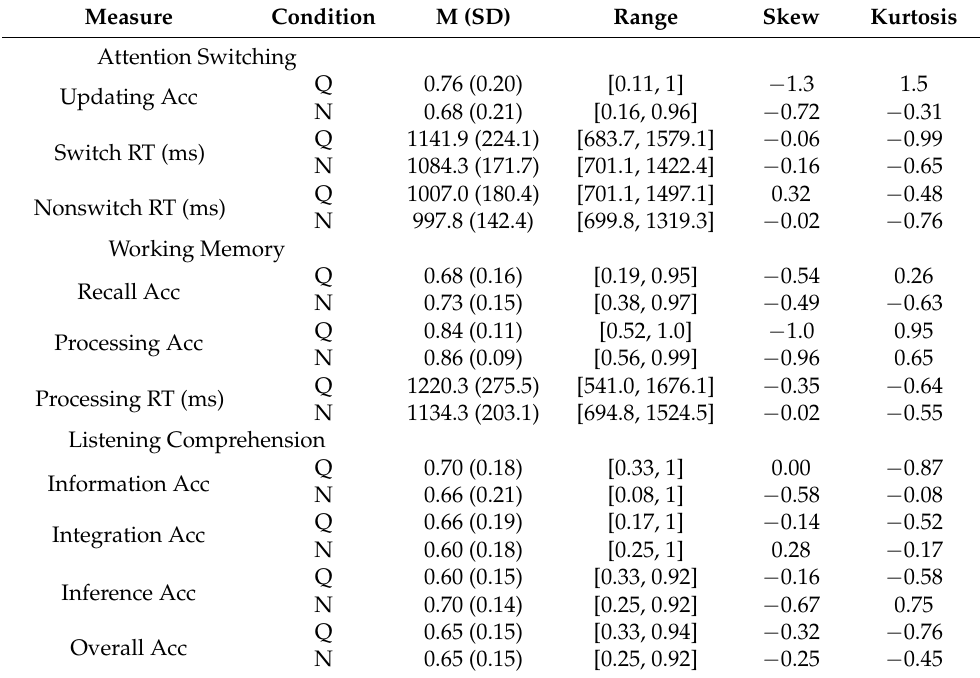
Table 1. Descriptive data for all the experimental tasks for both quiet and noise